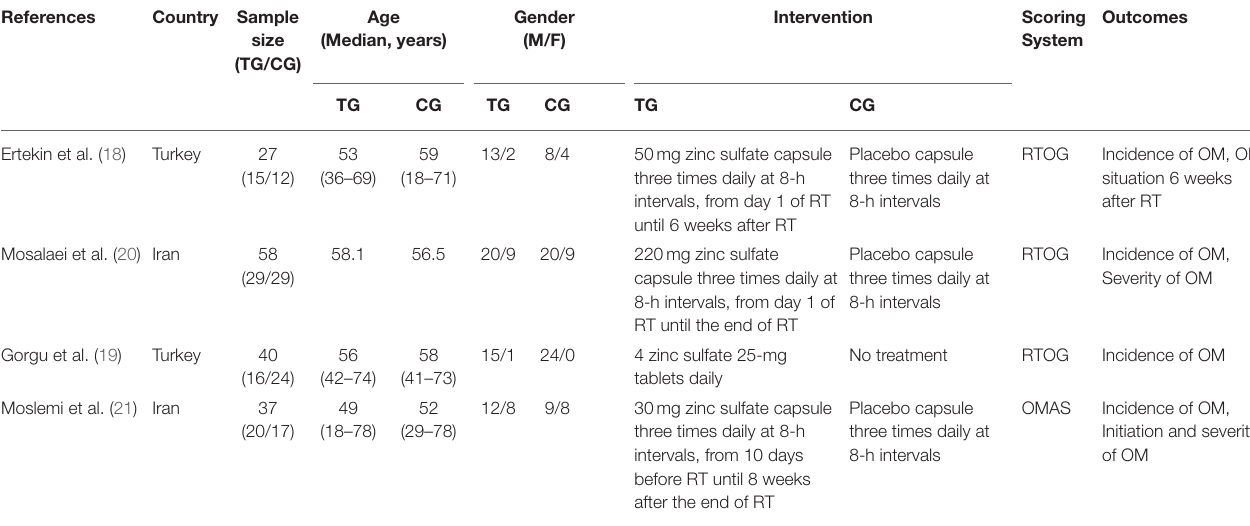
TABLE 2 | The basic characteristics of the four included study.